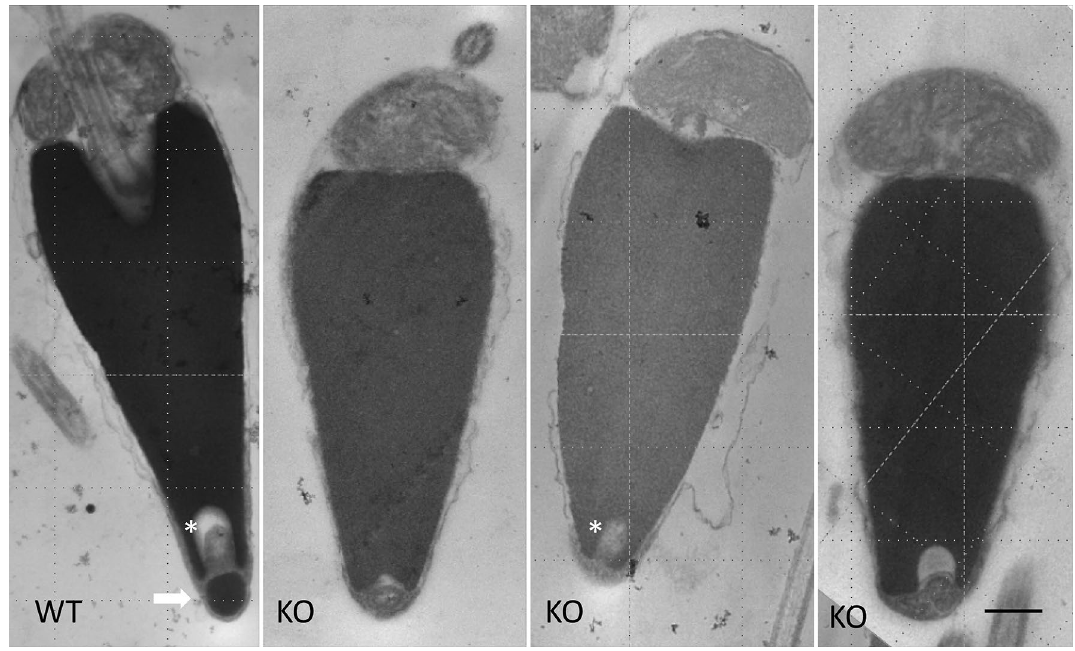
Figure 5. TEM of Wildtype and Bindin-null sperm. Note the acrosome of the wildtype sperm (white arrow) with densely packed Bindin. Three representative sperm from the bindin-KO adult (Bindin #3) still have an acrosomal vesicle, but it appears less dense, and vacuolated. Note the horseshoe shaped fossa (asterisks) within the sperm nucleus even in the sperm lacking bindin. Scale bar = 0.5 µm.